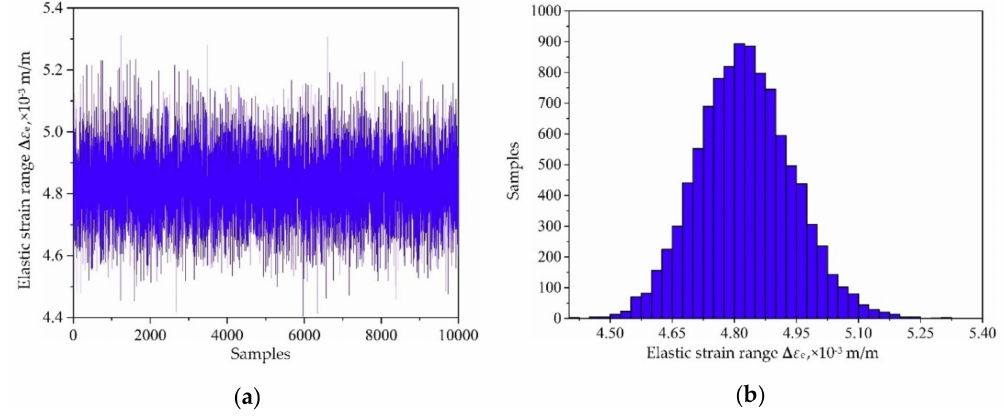
Figure 11. Output responses of decomposed IKM-2: ( a ) simulation history and, ( b ) probabilistic distribution.